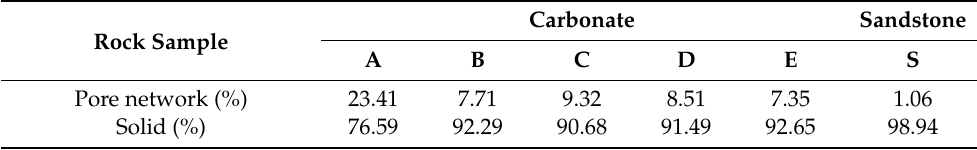
Table 2. Volumetric fractions of pore and solid in the rock samples. Rock Sample